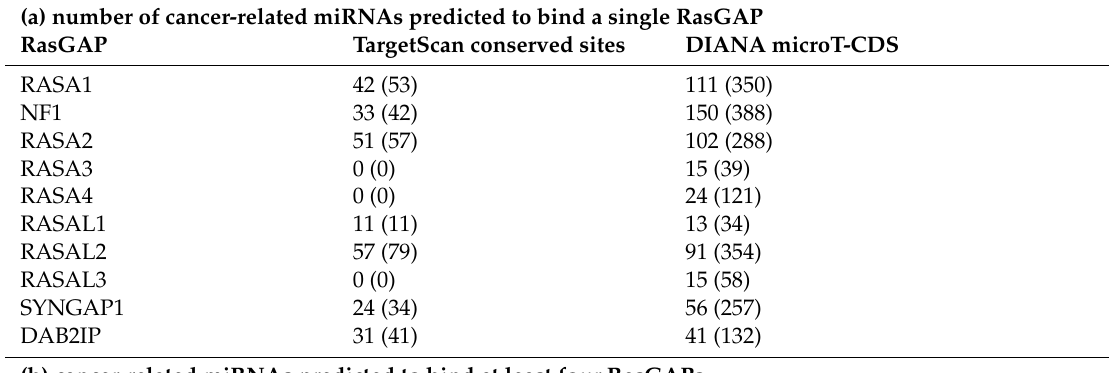
Table 2. Cancer-related miRNAs potentially targeting 10 human